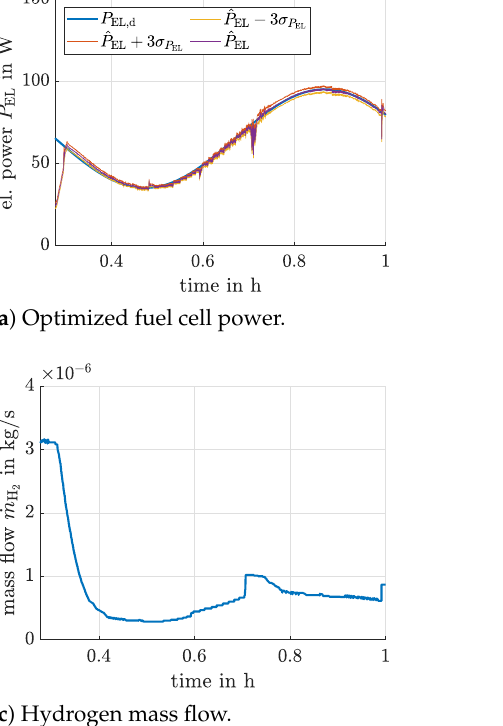
Figure 14. Input optimization for the integer-order system model for sinusoidal changes of the desired electric